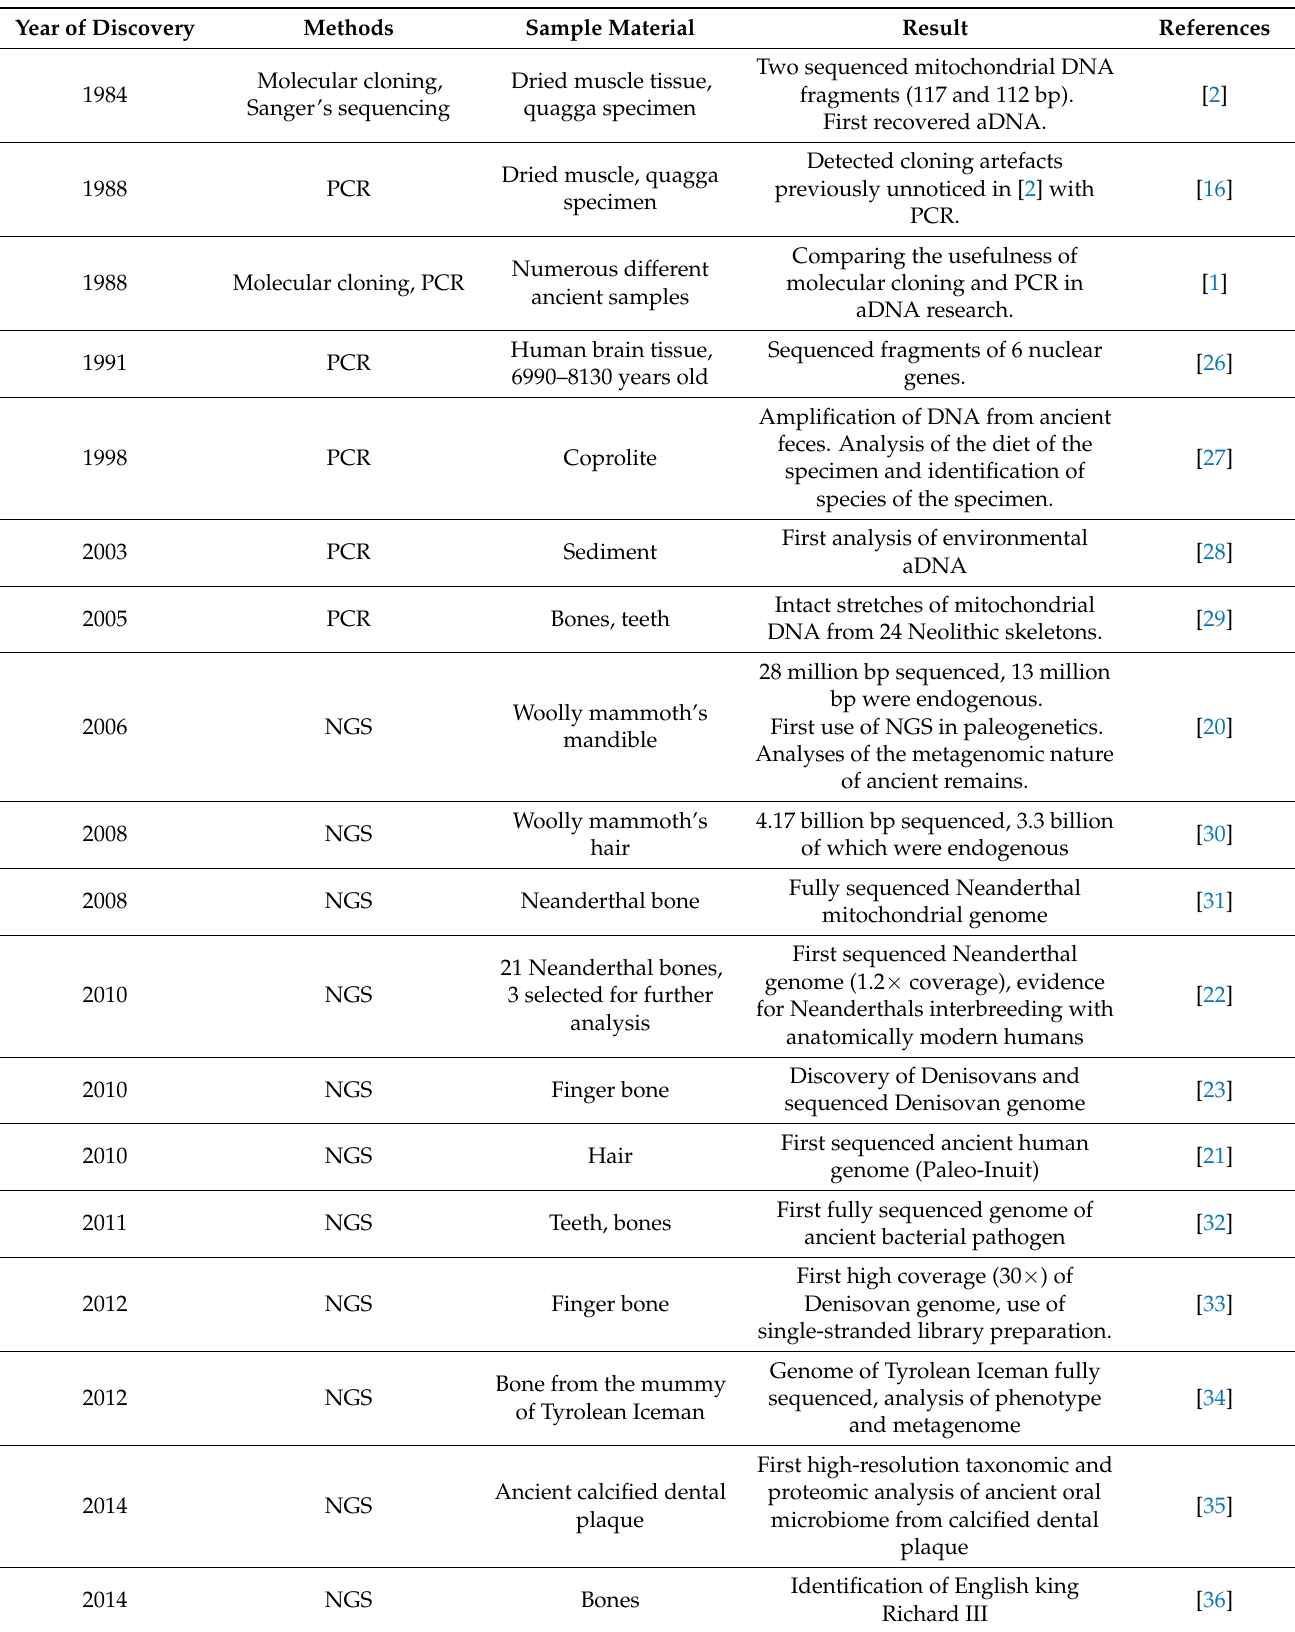
Table 1. Notable achievements in the field of ancient DNA